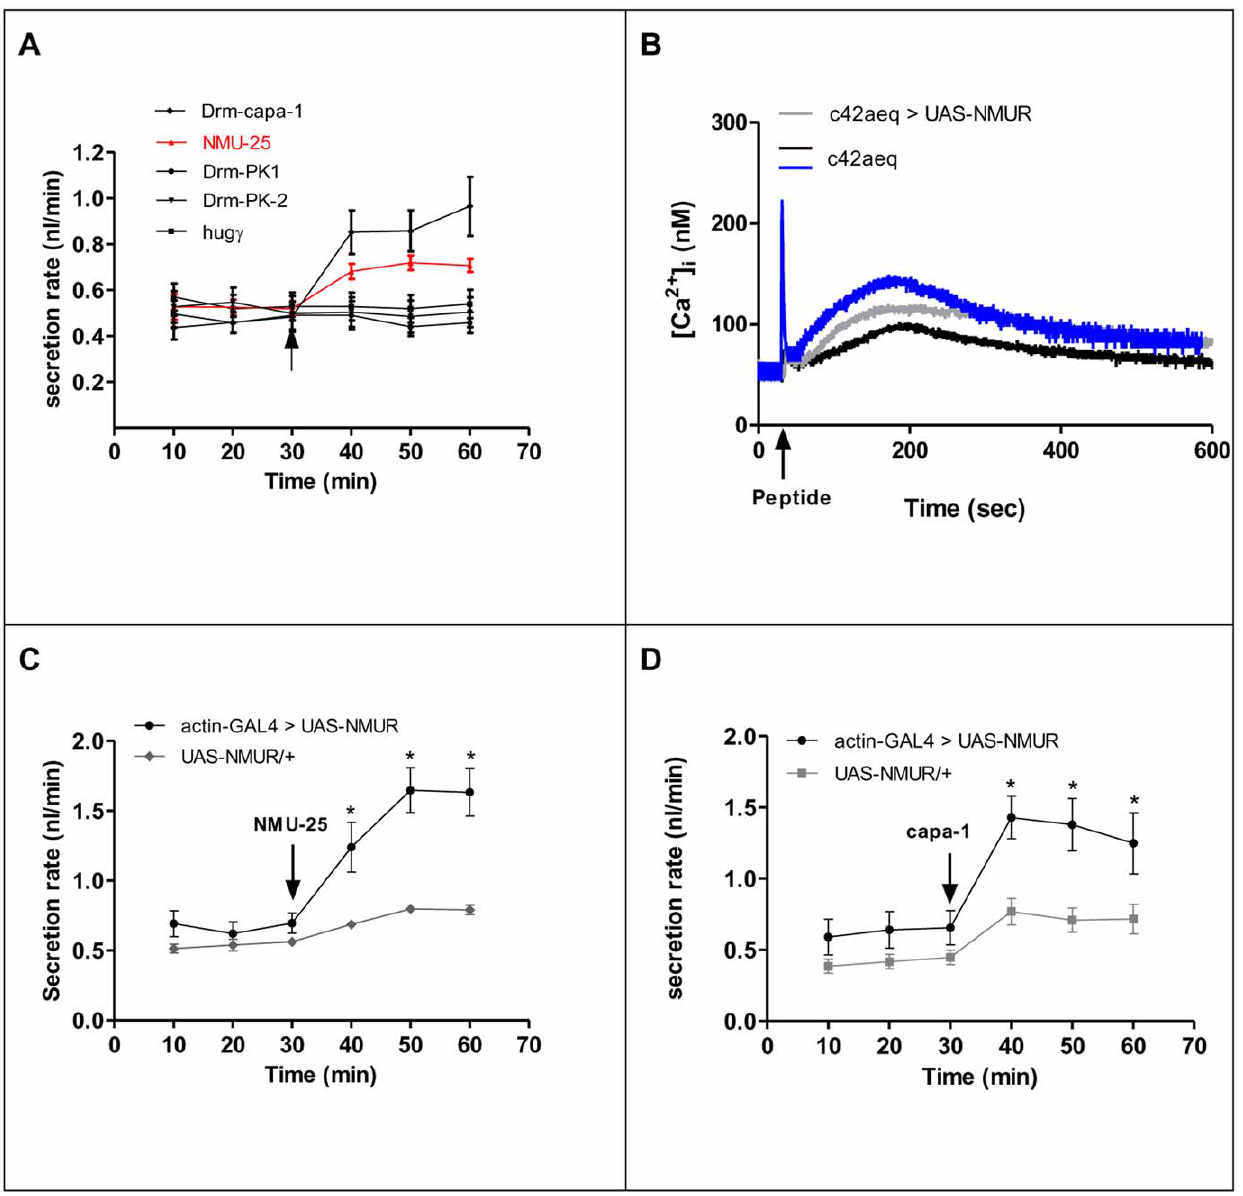
Figure 4. Functional role of NMU invivo . ( A ) Fluid transport by Drosophila wild-type tubule is significantly increased after application of the peptides Drm-capa-1 and NMU-25 at 10 2 7 M but not with Drm-PK-1, hugg, Drm-PK-2. ( B ) [Ca 2 + ] i levels in NMU-25-stimulated (10 2 7 M) transgenic tubules expressing UAS-NMUR 2 and apoaequorin transgenes driven by c42-GAL4 (grey) compared with a typical control response (black, c42aeq). The calcium trace in blue represent a typical biphasic capa-1 (10 2 7 M) response in tubule principal cells. Pooled cytosolic [Ca 2 + ] data from separate experiments are shown where data are nM [Ca 2 + ] 6 SEM, N =6, where P , 0.05. ( C ) NMU-25 (10 2 7 M) stimulates increased fluid transport in transgenic tubules, in which UAS-NMUR 2 was driven by actin-GAL4. ( D ) capa-1 (10 2 7 M) stimulates increased fluid transport in transgenic tubules, in which UAS-NMUR 2 was driven by actin-GAL4. Data are expressed as mean fluid transport rate (nl/min) 6 SEM, N=6–10. The level of significance in A, C and D was determined using a Student’s t -test (* P , 0.05) and in C and D, statistical analysis was confined to the comparison between the parental and progeny response.